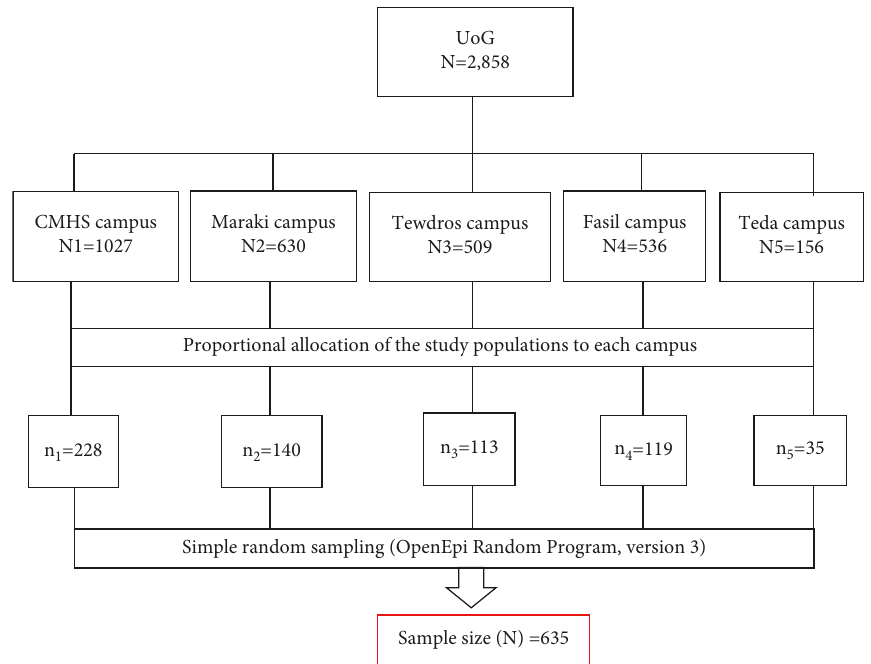
Figure 1: Schematic presentation of sampling procedure for the study of work-related upper extremity disorders among teaching staff in the University of Gondar,